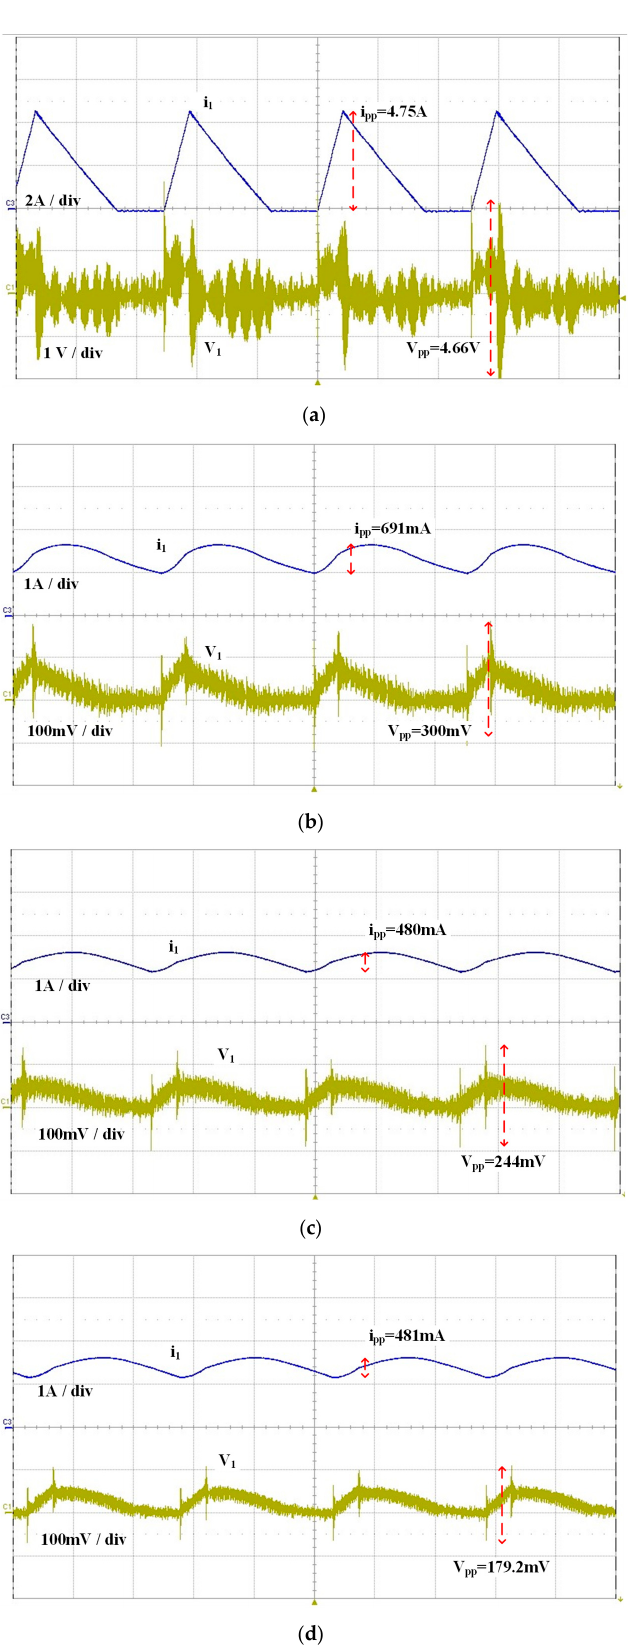
Figure 19 . Output voltage and current ripple with ( a ) no capacitor, ( b ) an electrolytic capacitor, ( c ) an electrolytic and an aluminum solid capacitors and ( d ) an electrolytic , an aluminum solid and a MLCC capacitors.